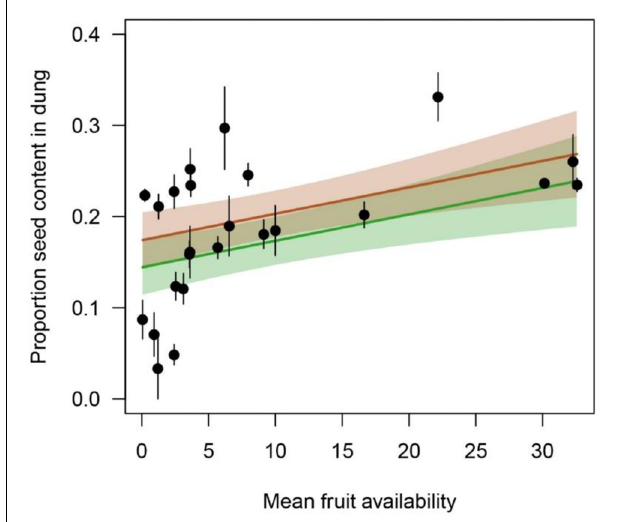
FIGURE 4 | Predicted relationship between the proportion seed content of dung and average fruit availability on fruit walks at the month level. Where: solid colored lines = site level predictions for Ivindo (green) and Wonga Wongué (brown); colored polygon = 95% confidence interval around the fixed effect of fruit abundance; black points = average proportion of seed content in dung by month from the raw data; black bars = standard error of the mean for the raw data.